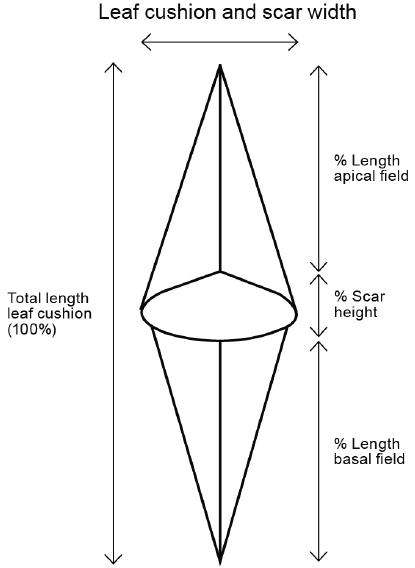
Figure 1. Schematic leaf cushion organisation: Total length and width leaf cushion, length apical and basal field leaf cushion, height and width leaf scar.